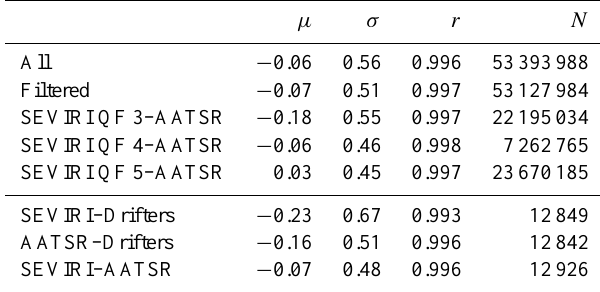
Table 2. Statistics of SEVIRI, AATSR and Drifters. The mean bias is defined as µ , the standard deviation as σ and the number of match-ups, N . All match-ups are with AATSR uncertainties ≤ 0.8K included and the SEVIRI skin correction. Filtered match-ups are based on µ within the interval µ ± 4 × σ . The upper five rows show the statistics of SEVIRI–AATSR match-ups. The bottom three rows include the statistics based on the availability of drifting